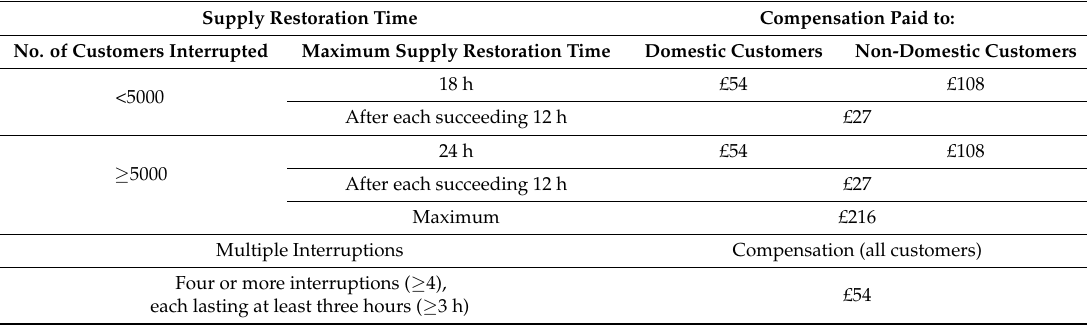
Table 4. The UK Guaranteed Standard of Performance